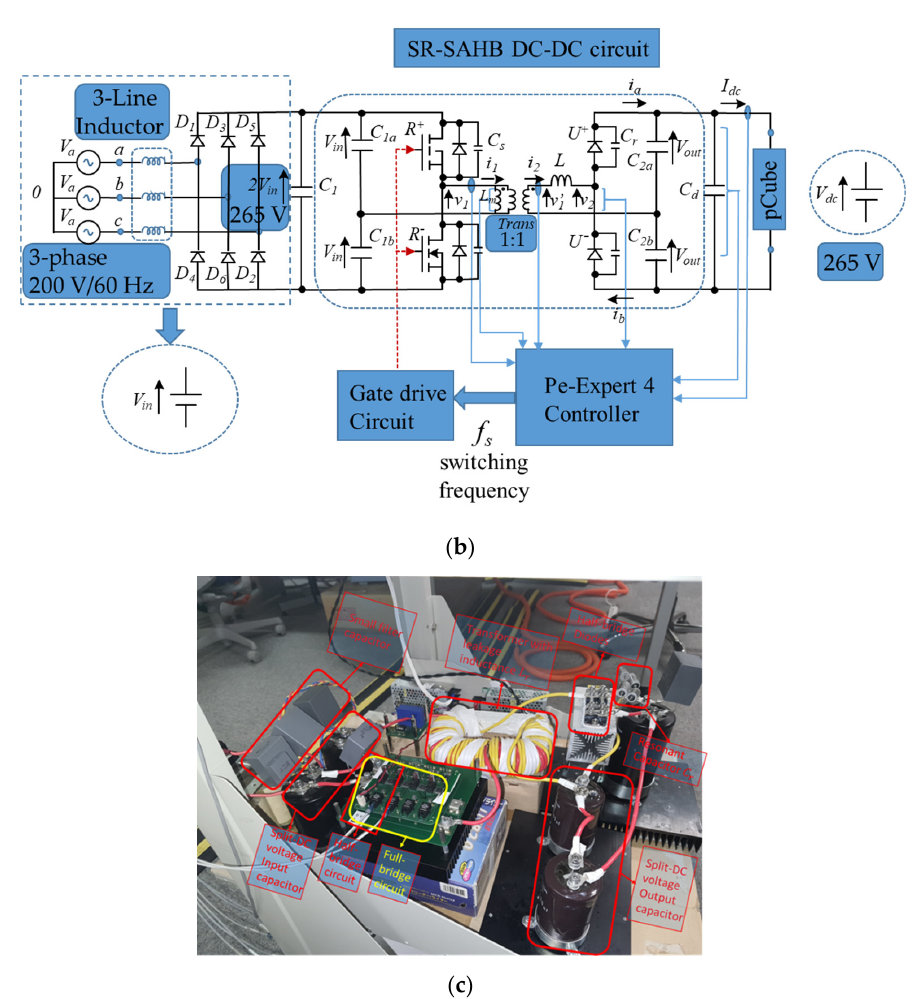
Figure 8. ( a ) Proposed SR–SAB DC-DC 265VDC/265VDC converter experimental setup; ( b ) Proposed SR–SAB DC-DC 265VDC/265VDC converter electrical diagram; ( c ) Prototype of the SR-SAHB DC-DC 265VDC/265VDC converter.